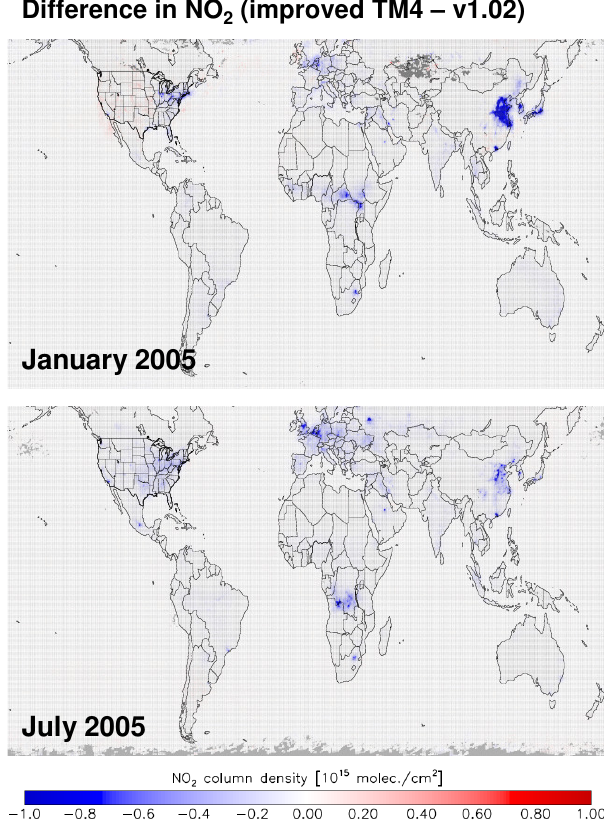
Fig. 7. Differences in retrieved OMI tropospheric NO 2 columns as calculated with the improved TM4 simulations minus v1.02. Values are monthly means for January 2005 (upper row) and July 2005 (bottom row).